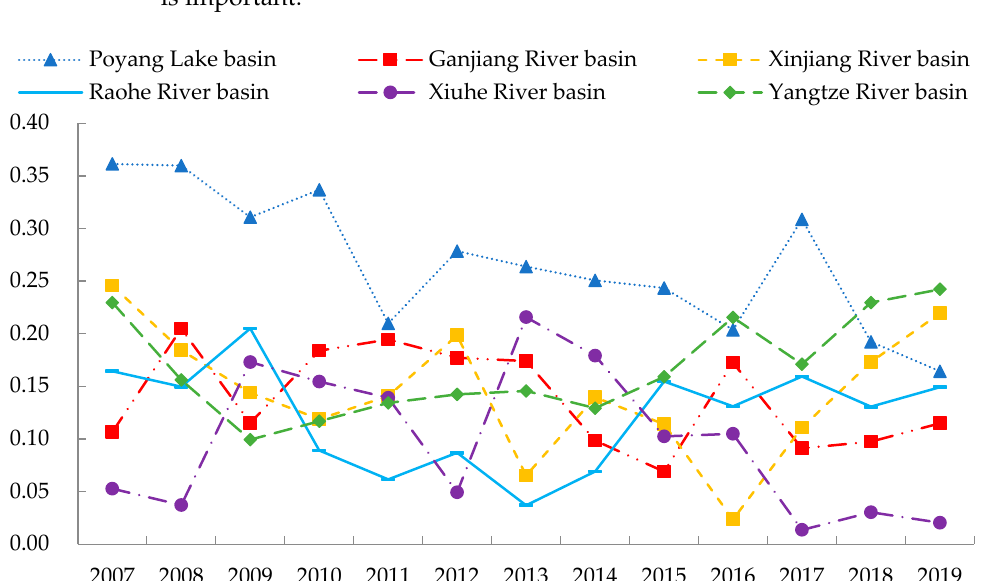
Figure 6. Intra-basin differences of EWP in the Poyang Lake area from 2007 to 2019.